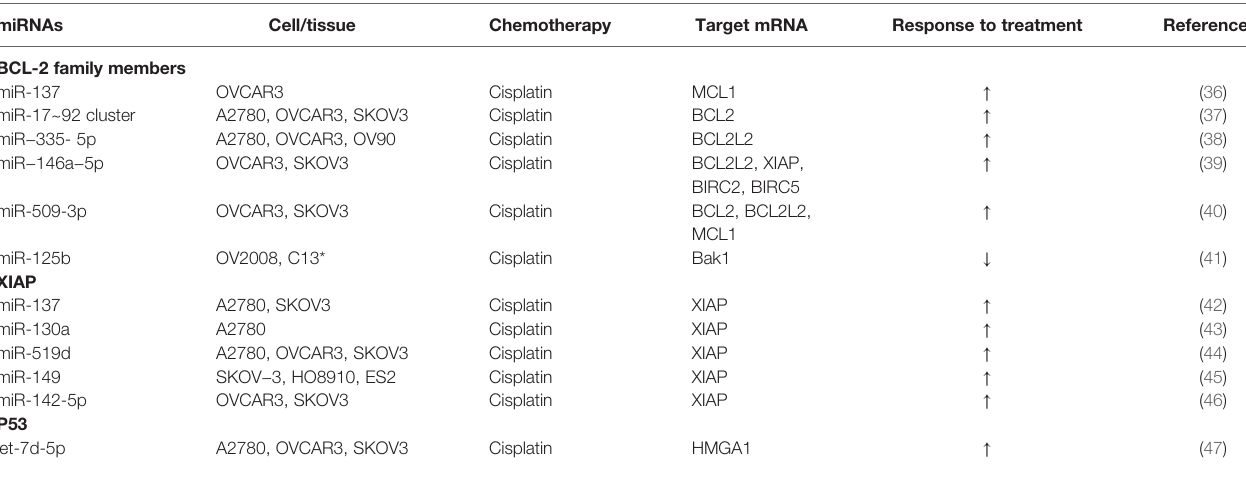
TABLE 3 | MiRNAs that modulate chemoresistance through apoptosis related proteins in OC.